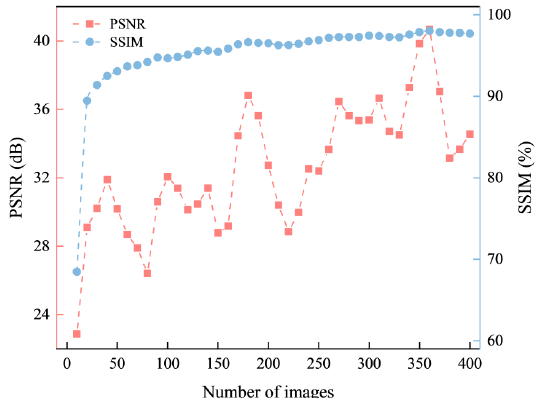
Figure 8. PSNR and SSIM indexes.